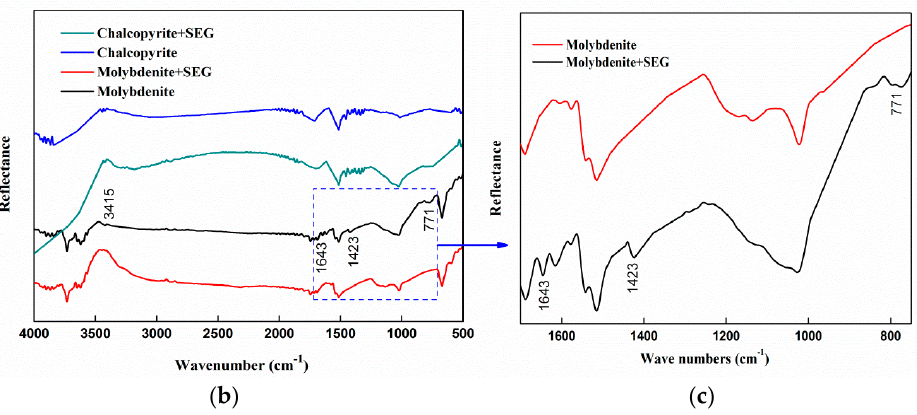
Figure 10. FT-IR spectra of ( a ) SEG and ( b ) these two minerals before and after interacting with the SEG system and ( c ) the amplified spectrum of molybdenite from 830 to 1700 cm − 1 .